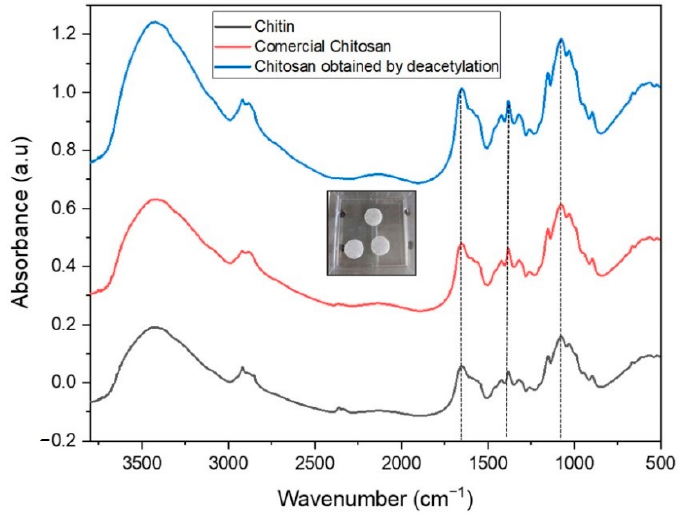
Figure 1. Transmission IR spectra (using the KBr pellet technique) of chitin (black spectrum), commercial chitosan (red spectrum), and deacetylated chitosan (blue spectrum) to determine the influence of DD on the efficiency of chitosan against bacterial biofilms.